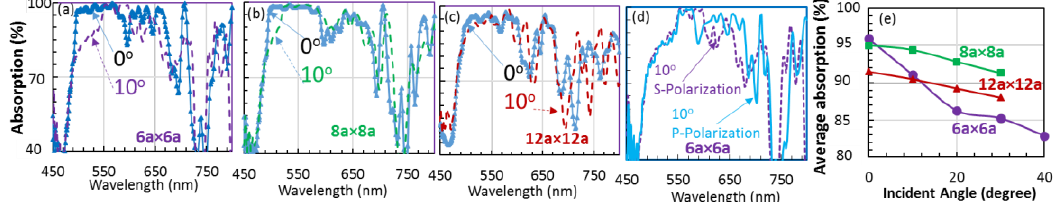
Figure 3. ( a – c ) Simulated light absorption in Si device patterned with GPSC with a unit super-cell size of 6a × 6a ( a ), 8a × 8a ( b ) and 12a × 12a ( d ) (a = 350 nm), respectively. ( d ) Shows the absorption from s-polarization and p-polarization light incident at 10 degrees for Si device patterned with GPSC with a unit super-cell size of 6a × 6a. ( e ) Average light absorption between 500–650 nm as a function of incident angles.